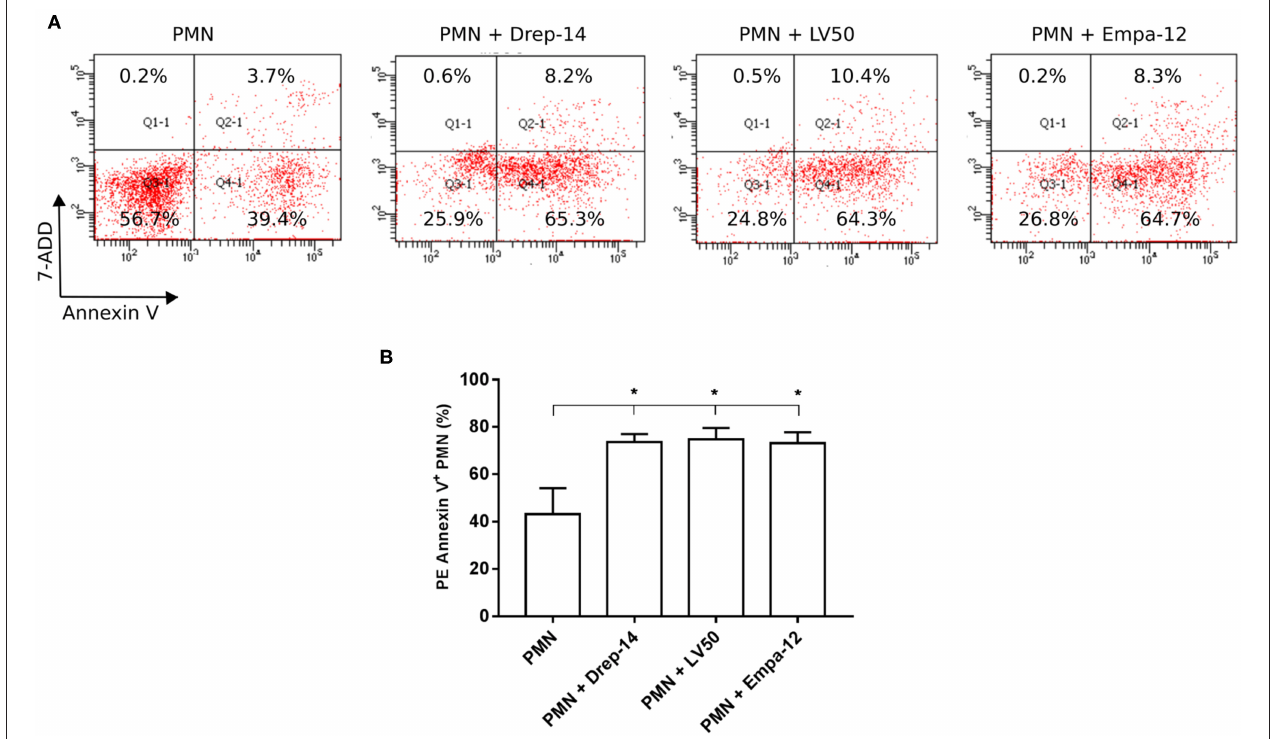
FIGURE 5 | Increased neutrophils apoptosis upon Leishmania promastigotes infection. Neutrophils isolated from three donors were infected or not with Leishmania parasites (MOI of 10). After 18h of infection, the cells were labeled with PE Annexin V / 7-ADD and analyzed by FACS. (A) Representative dot plots of non-infected PMN and PMN infected with Drep-14 (PMN + Drep-14), with LV50 (PMN + LV50) or with Empa-12 (PMN + Empa-12) were labeled with Annexin V vs. 7-ADD. The plots illustrate the results obtained for one of three donors tested. (B) Percentage of PMN Annexin V + of non- infected and infected PMN of three donors. Data are shown as mean percentage of apoptotic PMN ± SD. Pair- wise comparisons of the non-infected PMN vs. each strain- infected PMN were performed using the Mann–Whitney test; * p < 0.05 indicates statistically significant